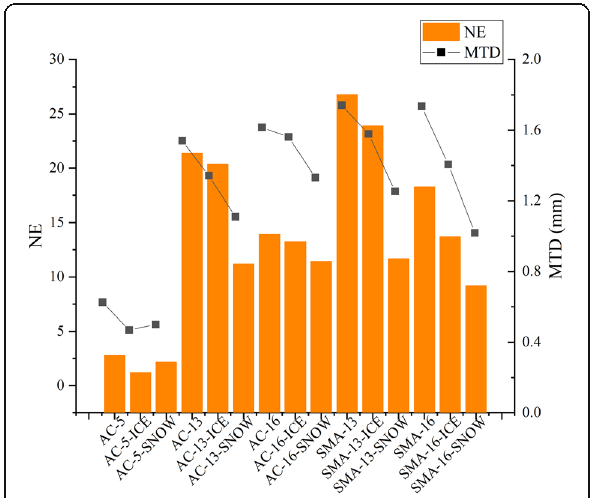
Fig. 13 Comparison between MTD and NE for 50% cutting plane